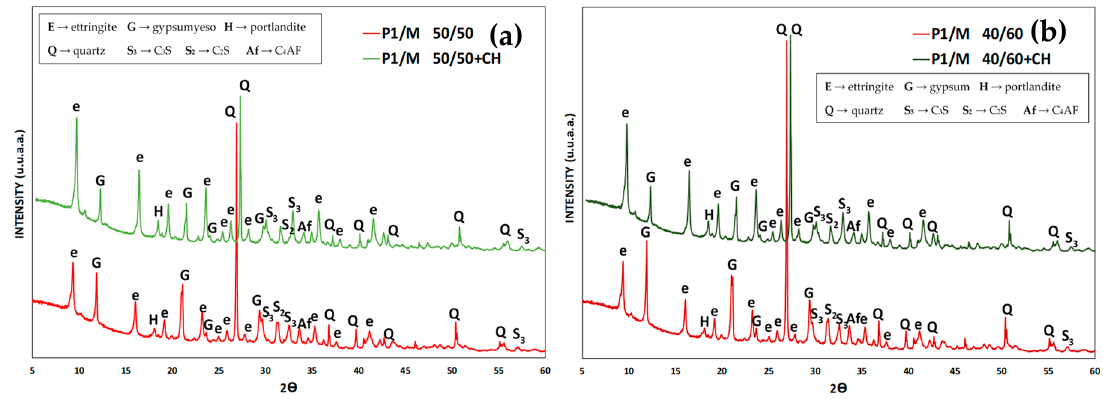
Figure 5. XRD patterns. ( a ) P1 / M 50 / 50 and P1 / M 50 / 50 + CH. ( b ) P1 / M 40 / 60 and P1 / M 40 / 60 + CH. L-A specimens at 28-days.